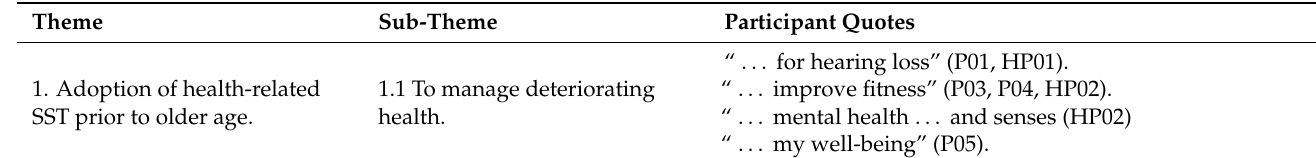
Table 1. Research Question 2